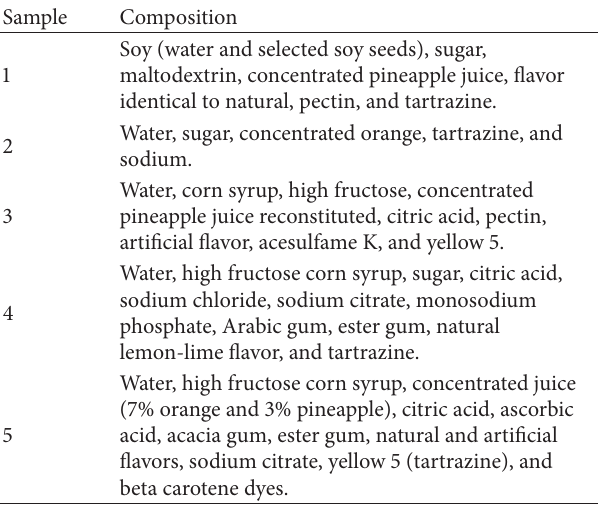
Table 6: Chemical composition of the analyzed commercial bever- ages.